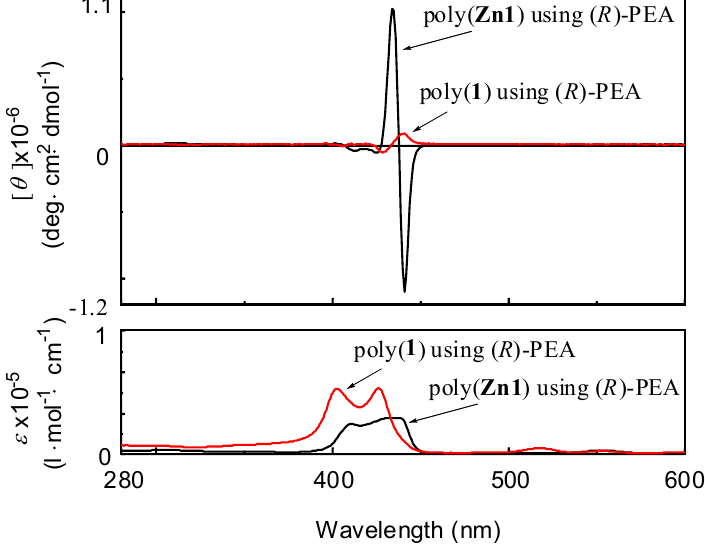
Polymers 2019 , 11 , 274 8 of 11 Figure 2. CD and UV-vis spectra of poly( 1 ) and poly( Zn1 ). Figure 2. CD and UV-vis spectra of poly( 1 ) and poly( Zn1 ).